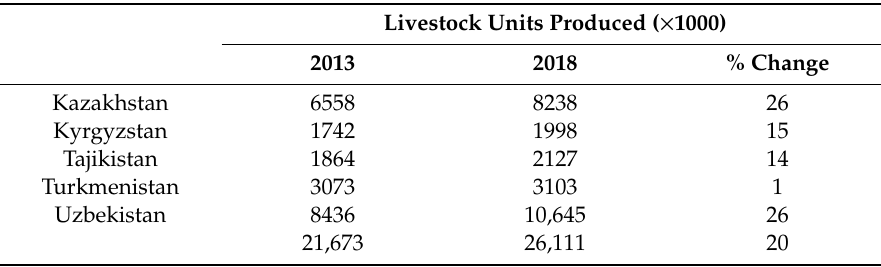
Cattle, horse = 0.65 unit; sheep, goat = 0.1 unit [56].